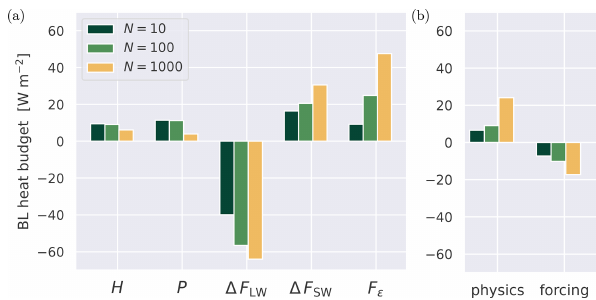
Figure 18. Analysis of the bulk (BL) heat budget of the boundary layer below the base of the capping inversion. (a) Bar plot of all physics terms in the sensible heat budget, plotted as energy fluxes. (b) The net contribution by all physics terms as shown in panel (a) and the large-scale forcing h ˙ θ LS